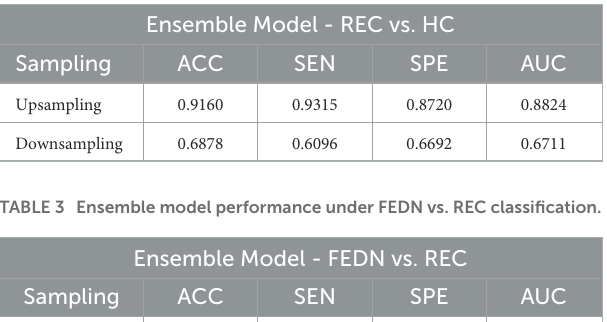
TABLE 2 Ensemble model performance for REC vs. HC classification.